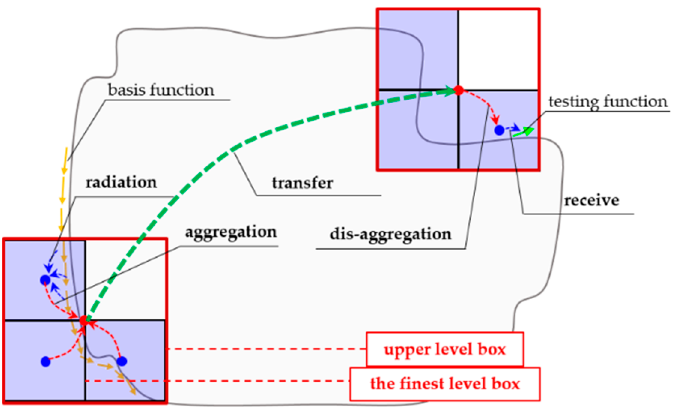
Figure 1. Outline of the MVP calculations in the conventional MLFMA.